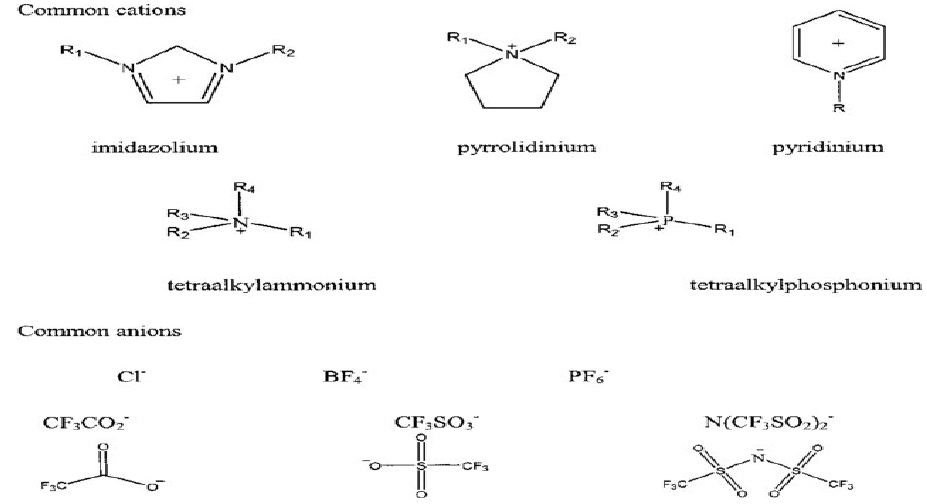
Figure 3. Structures of common cations and anions of ionic liquids [50].